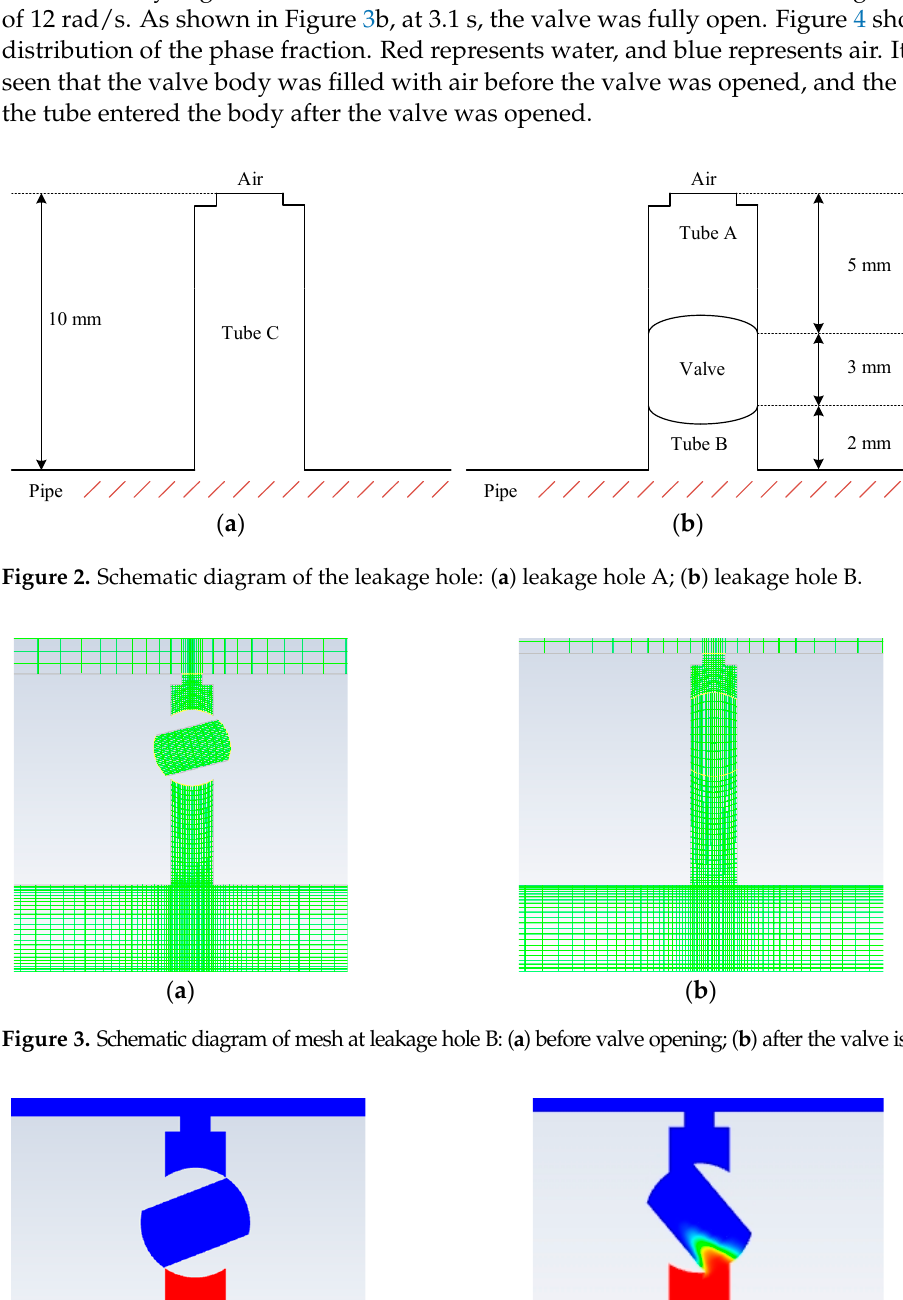
Figure 3. Schematic diagram of mesh at leakage hole B: ( a ) before valve opening; ( b ) after the valve is opened.